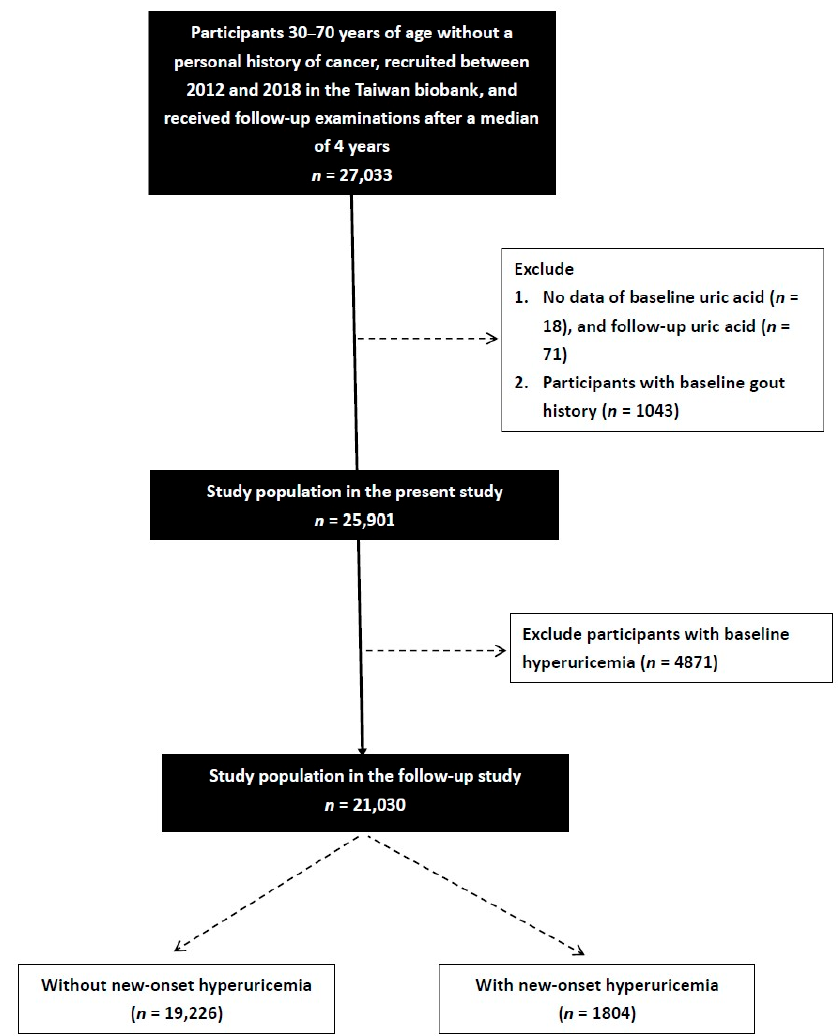
Figure 1. Flowchart of the study population.